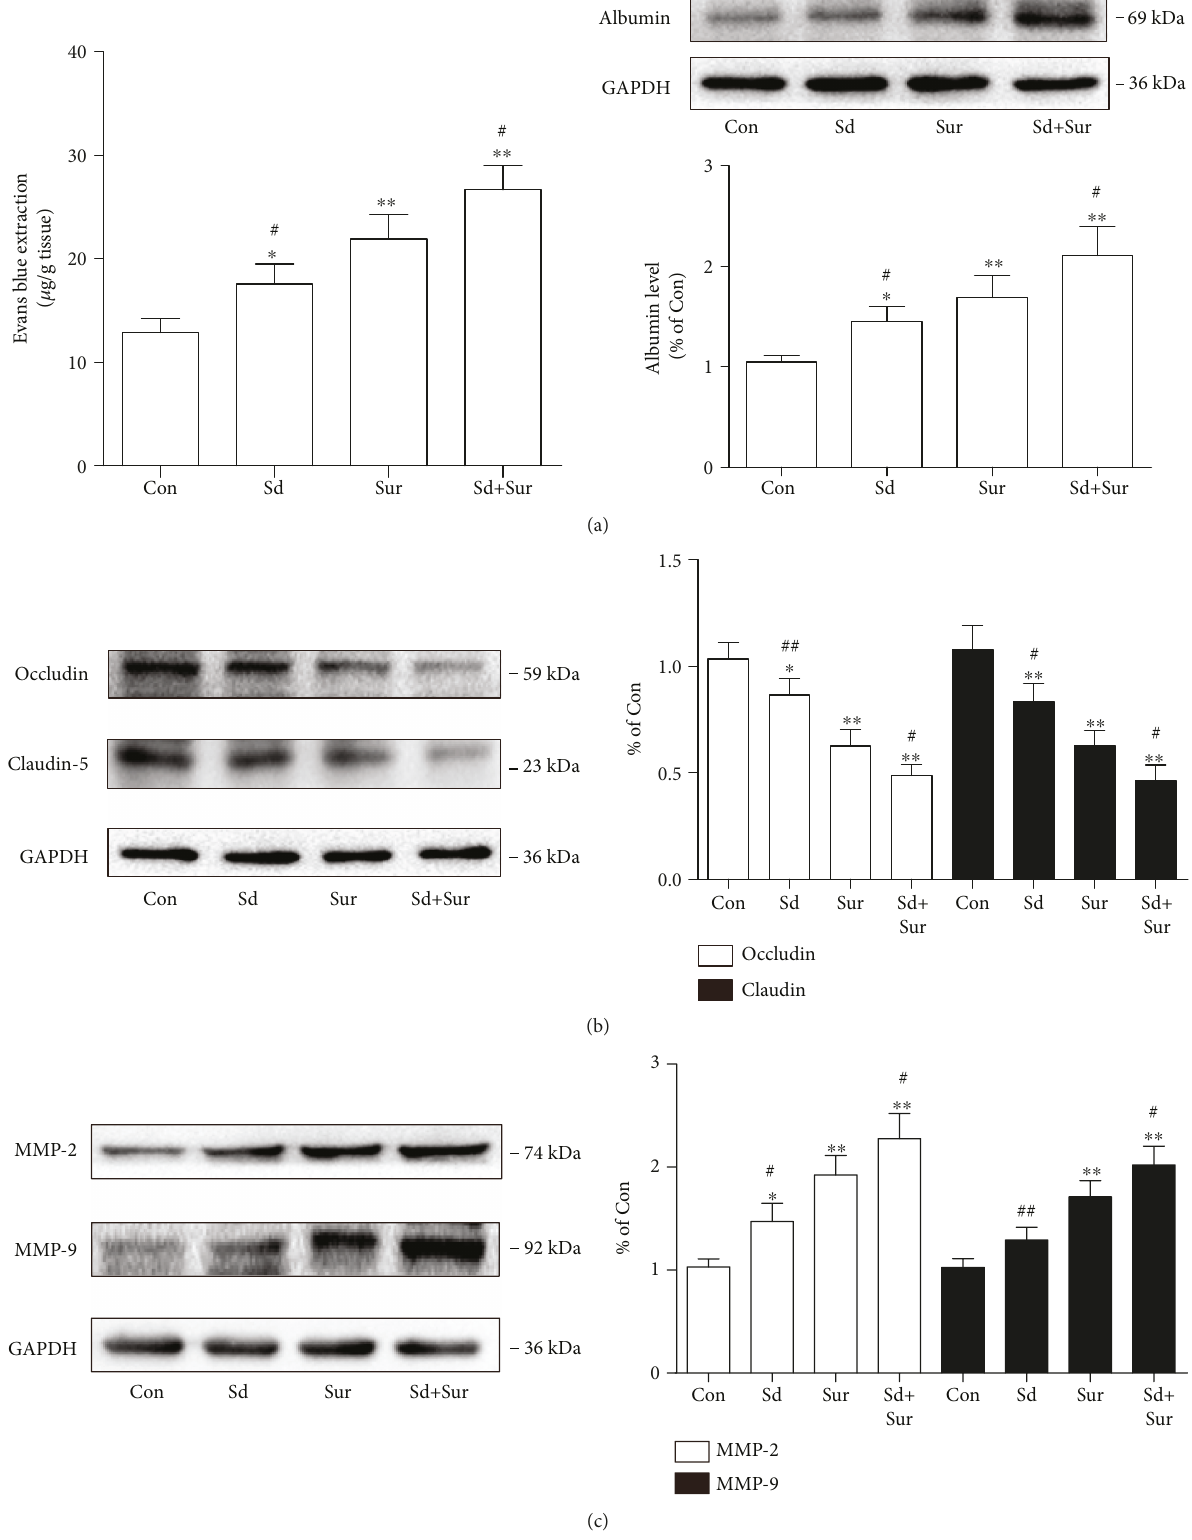
Figure 7: Preoperative sleep disturbance augmented operation-induced blood-brain barrier disruption. (a) EB content and the protein levels of albumin in the hippocampus. (b) Expression levels of occludin and claudin-5 protein in the hippocampus. (c) Expression levels of MMP-2 and MMP-9 protein in the hippocampus. The data are presented as the mean ± sem ( n = 4 ). ∗ P < 0 05 and ∗∗ P < 0 01 vs. the Con group; # P < 0 05 and ## P < 0 01 vs. the Sur